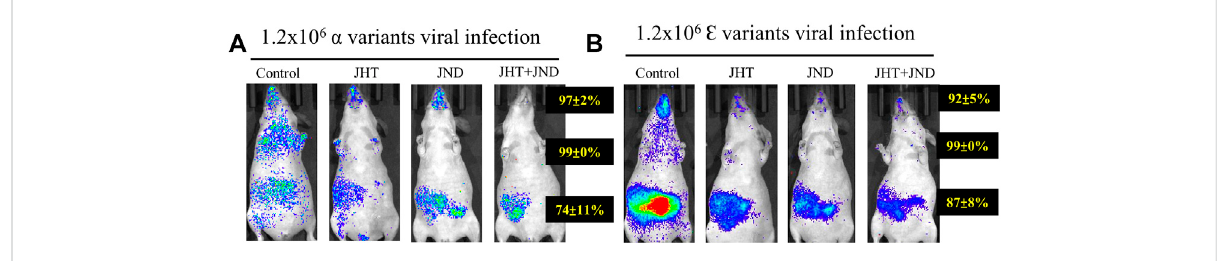
FIGURE 4 EffectoforalJHTandnasalJNDadministrationontheaccumulationofothervariantsinSKH-2mice.Alpha (A) andepsilon (B) variantsofSARS- CoV2-S-pseudotyped lentivirus infused with or without oral JHT (48.66 mg in 0.3 ml/day) or nasal JND (30 µL twice a day) administration